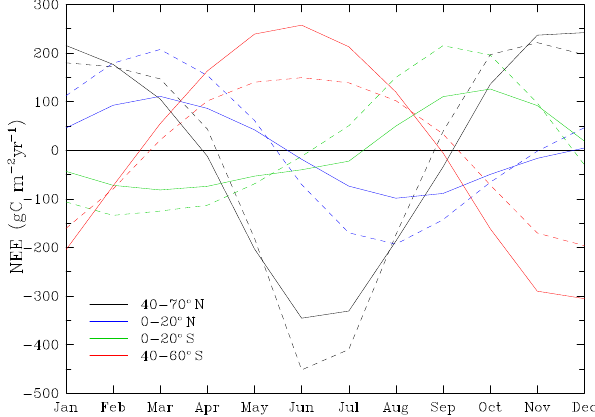
Figure 9. Monthly mean NEE in gCm − 2 yr − 1 for years 901–1000 averaged over the land grid cells in four latitude bands (as listed in the key), for PresLAI (dashed) and ProgLAI